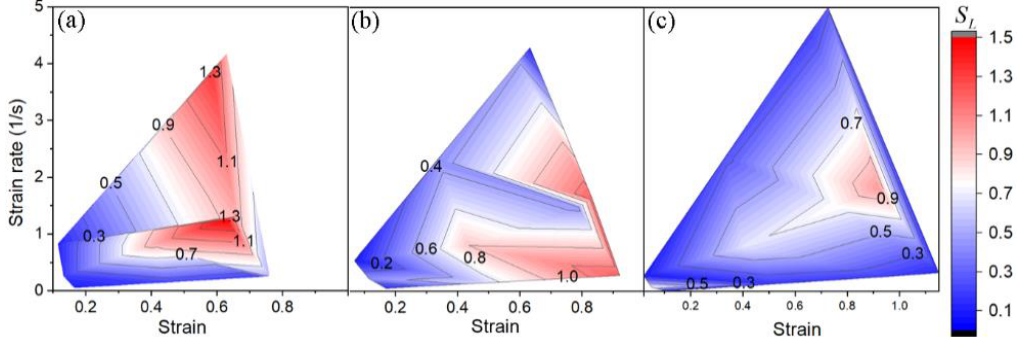
Figure 10. The effect of strain and strain rate on the fraction of low-angle boundaries depending on temperature, °C: ( a ) 300, ( b ) 400, ( c ) 500. The dependences are plotted from the results of the EBSD analysis of the microstructure.